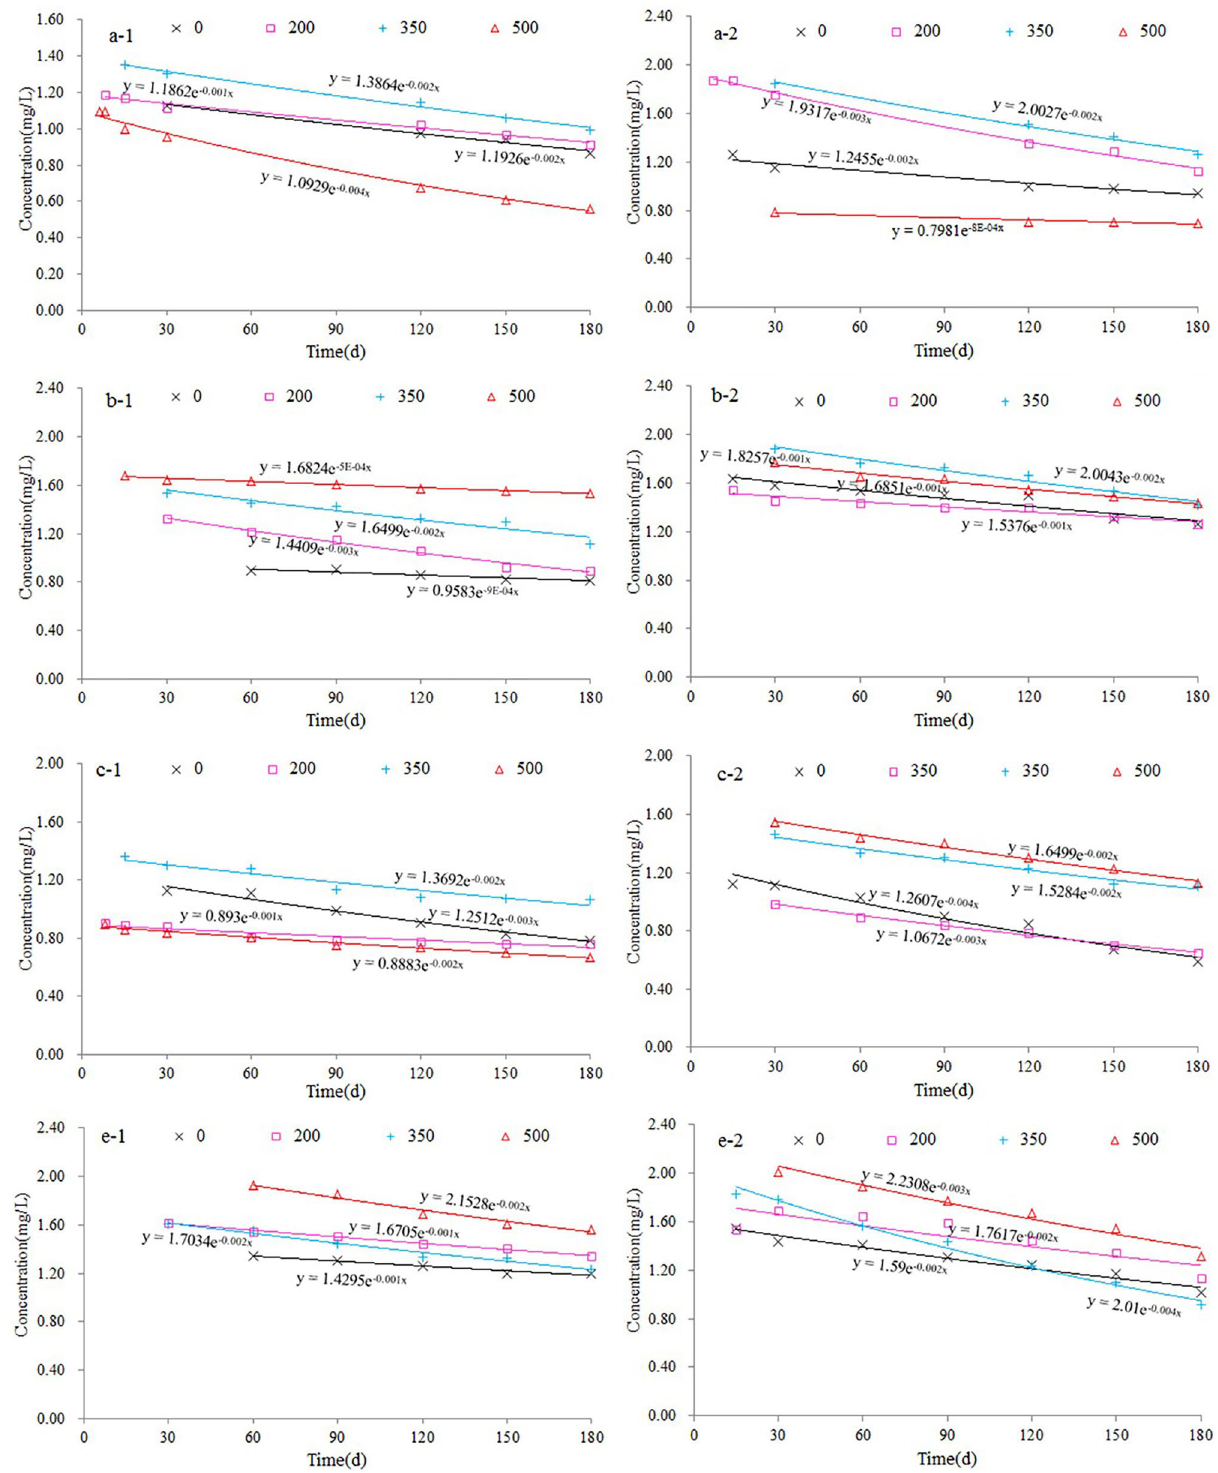
Figure 5. First-order decay kinetic equation of benzene and